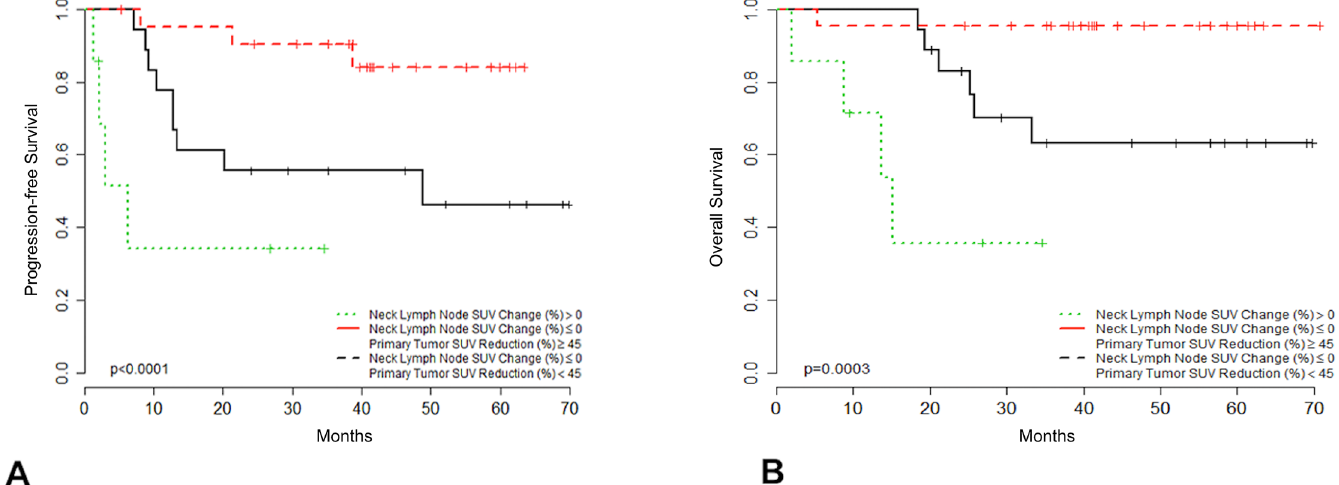
Fig 5. Clinical outcome according to primary tumor/neck lymph node SUV change after cycle 1 of IC. Progression-free survival (5A) and overall survival (5B) among patients according to maximum regional lymph node SUV change and primary tumor SUV change after the first cycle of induction chemotherapy (N = 47). Patients with responsive tumors (neck lymph node SUV change (%) (cid:20) 0) and maximum primary tumor SUV reduction (cid:21) 45% (N = 22; red) showed improved outcomes compared with patients with responsive tumors (neck lymph node SUV change (%) (cid:20) 0) and primary tumor maximum SUV reduction < 45% (N = 18; black), or with patients with unresponsive tumors (neck Lymph node SUV change (%) > 0; N = 7; green).